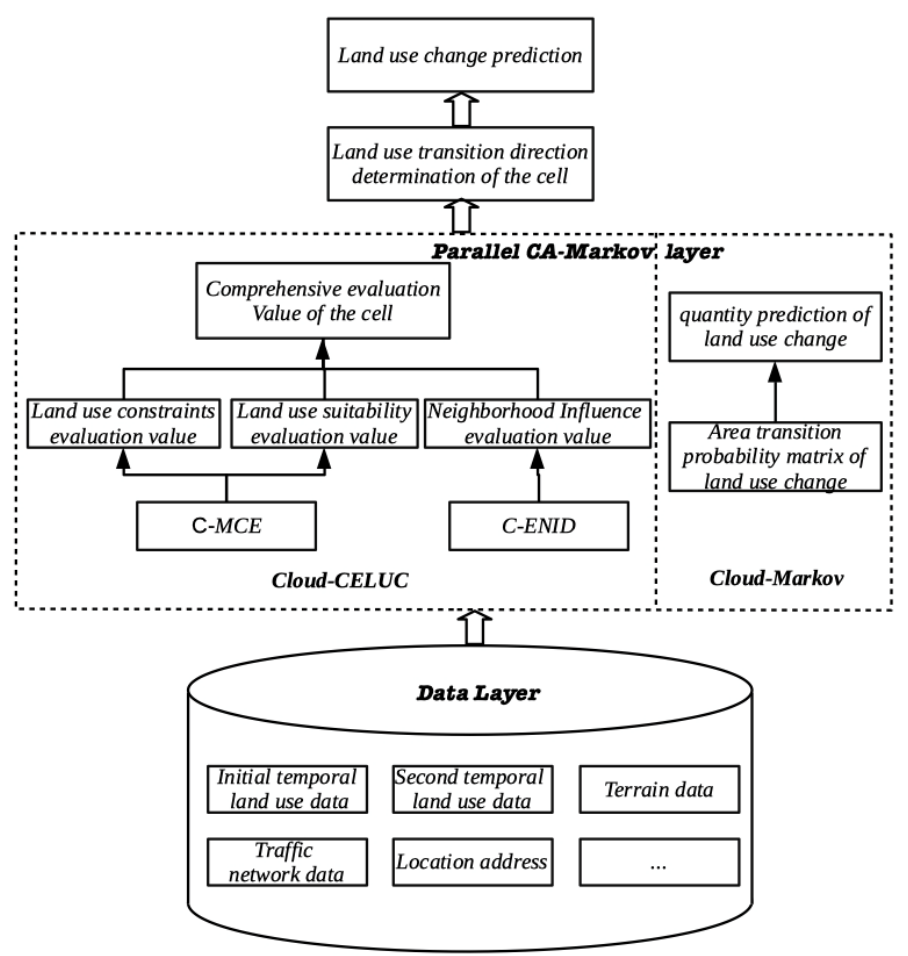
Figure 3. Structure of parallel cellular-automata Markov over MapReduce.